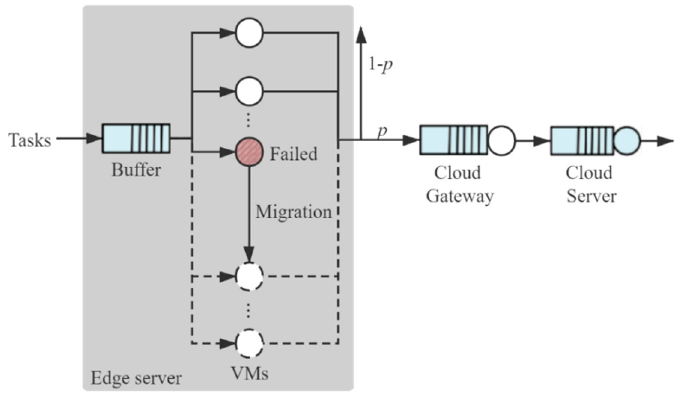
Figure 4. Queueing models through the network.